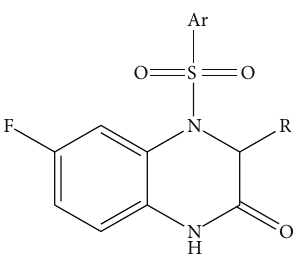
Figure 17: Chemical strucure of compound 50a – h .